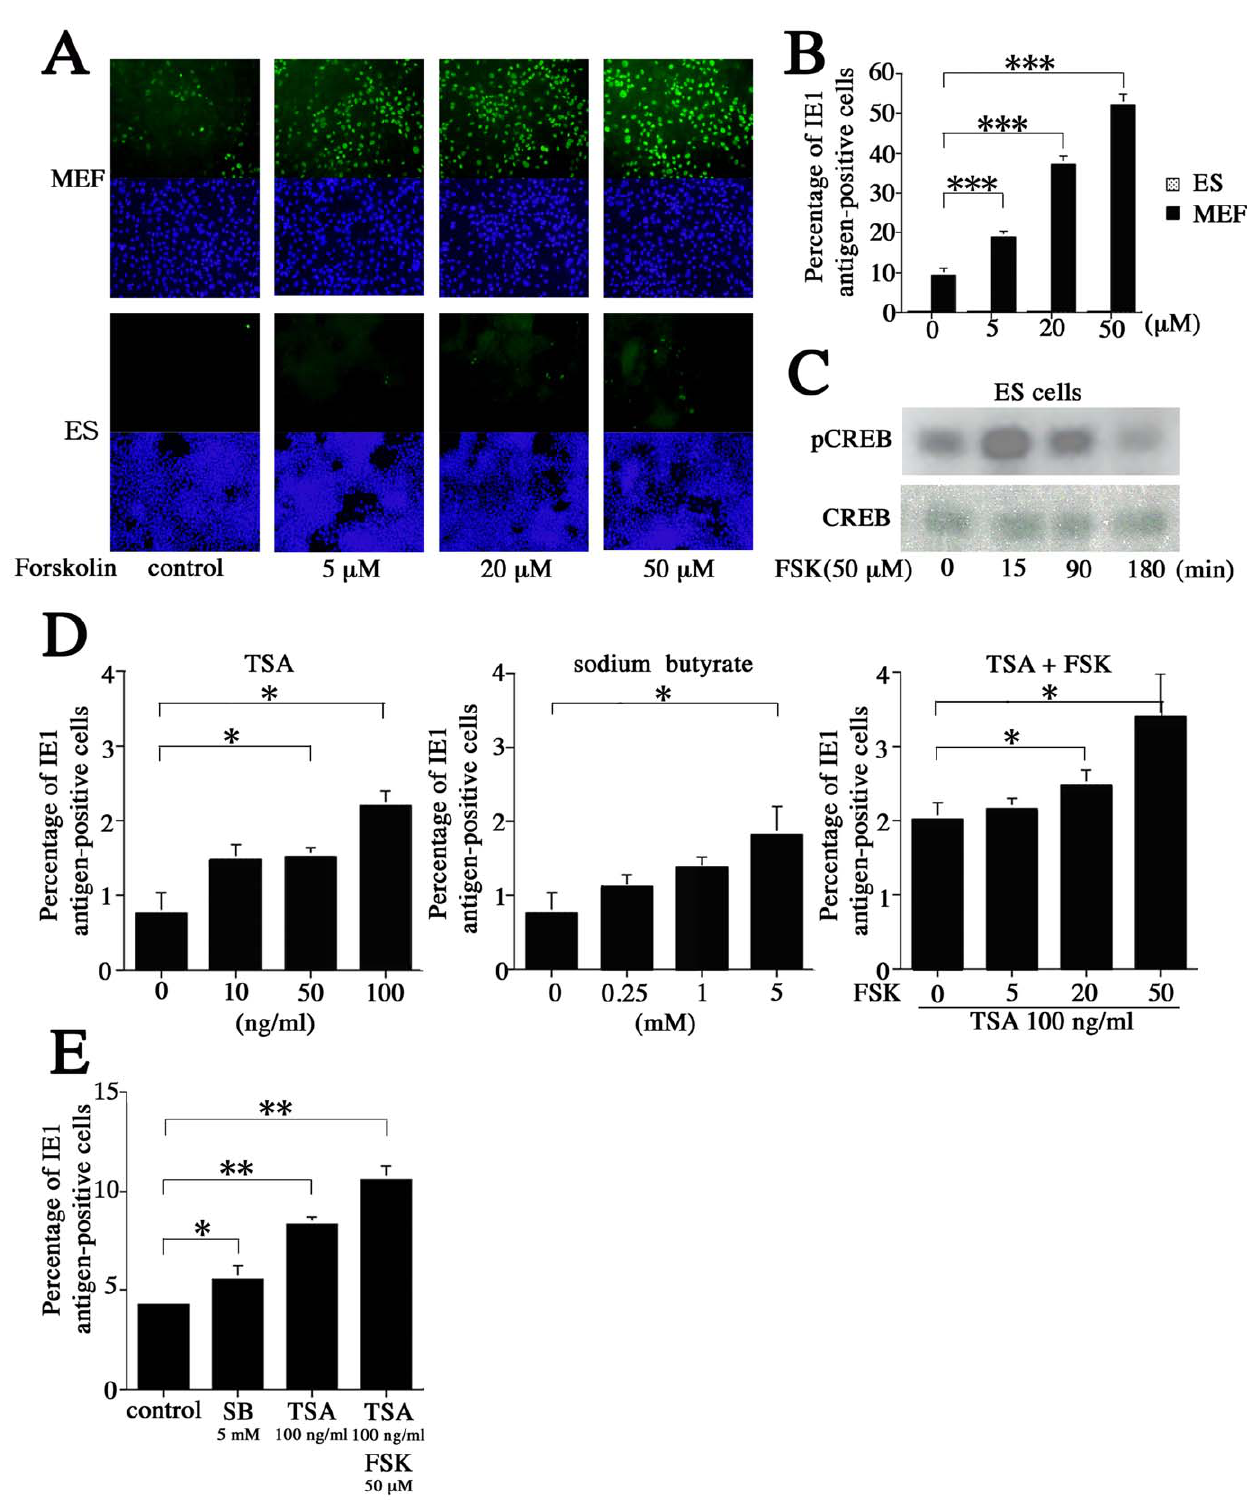
Figure 4. Response of the MCMV lytic cycle to treatment with FSK and TSA. Both (A) immunocytochemical and (B) flow cytometric analyses showed that treatment with FSK increases the proportion of IE1-positive cells in MEF cultures in a concentration-dependent manner ( P , 0.001), while only slight increases were seen in ES cells. (C) Western blot evaluating levels of phosphor-Ser 133 CREB after treatment with FSK. (D) Percentage of IE1 antigen-positive cells at 24 hpi in ES cells infected with MCMV at an MOI of 1 prior to treatment with TSA (left), sodium butylate (SB; middle), and a combination of TSA (100 ng/mL) and FSK (0–50 m M; right). (E) Percentage of IE1-positive cells in ES cells infected with MCMV at an MOI of 10 prior to treatment with SB (5 mM), TSA (100 ng/mL), or a combination of TSA (100 ng/mL) and FSK (50 m M). All presented experiments were performed at least 3 times, and data are given as the mean 6 SD. * P , 0.05. ** P , 0.01, *** P , 0.001, t- test.